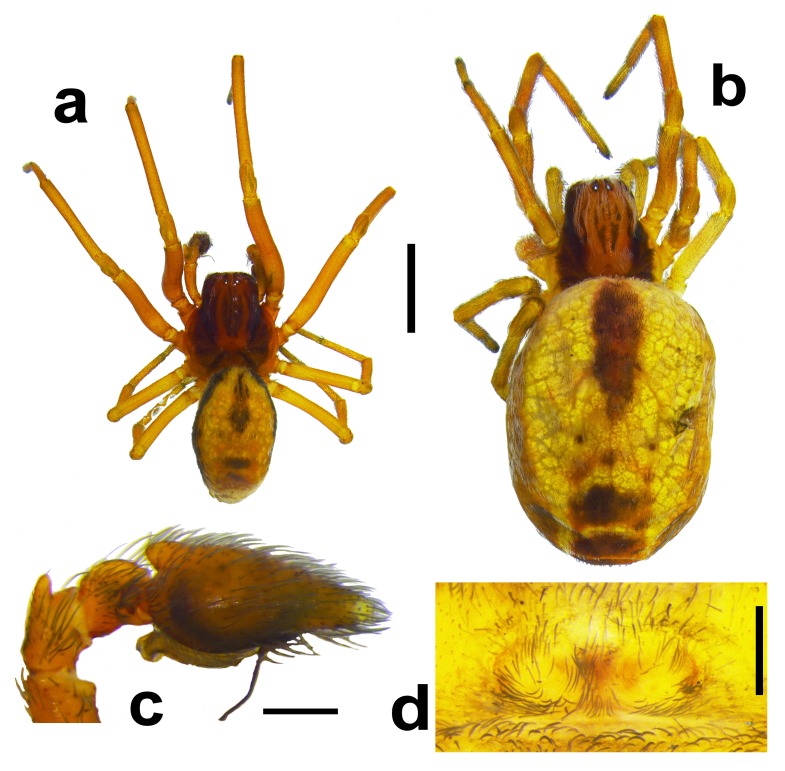
Nigma
gratiosa (Simon, 1881). a: male, dorsal habitus, scale = 1 mm; b: female, dorsal habitus, scale = 0.1 mm; c: right male palp, retrolateral, scale = 0.2 mm; d: female epigynum, ventral, scale = 0.2 mm.